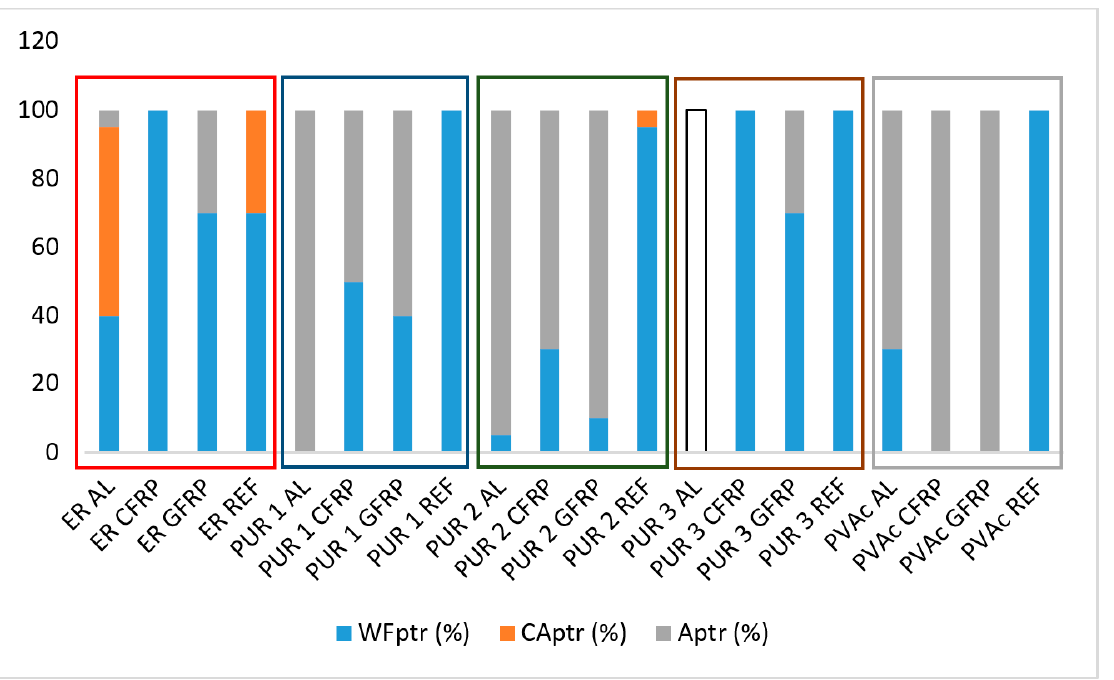
Figure 9. Failure proportions of climatically pre-treated samples (WF—wood failure, CA—cohesive failure of adhesive, A—adhesion failure).